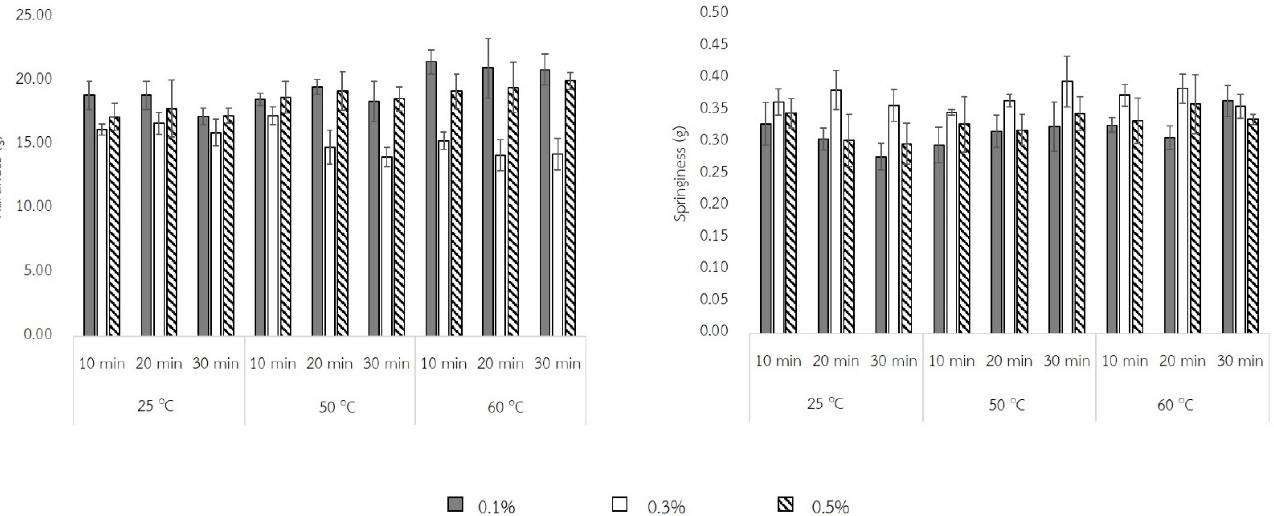
Figure 3. The hardness and springiness of each QBJR sample.